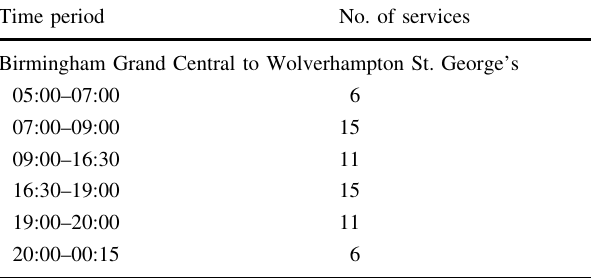
Table 4 No. of services from Wednesbury Parkway to Wolver- hampton St. George’s (section 4) Time